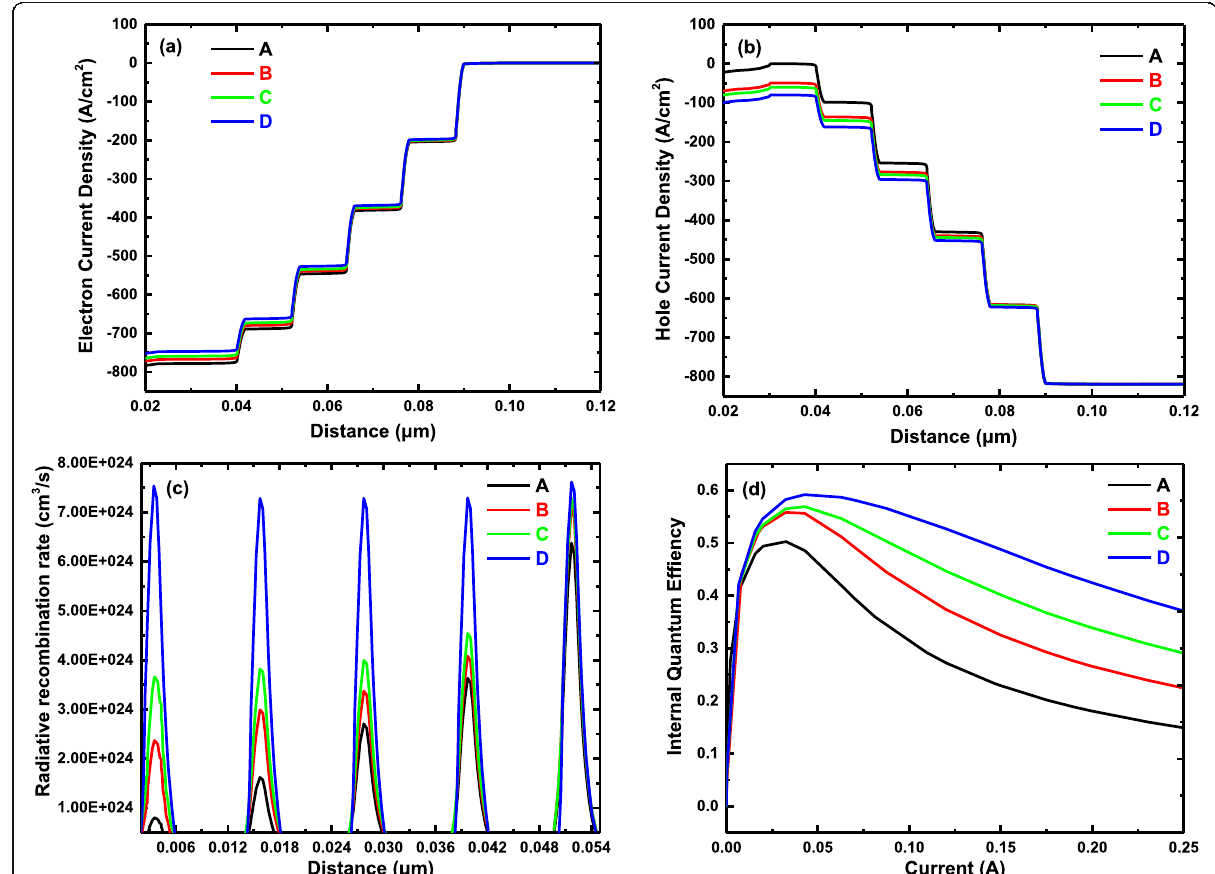
Fig. 4 Theoretical simulations and analysis. a Electron current density in the active region at the injection current of 200 mA. b Hole current density in the active region at the injection current of 200 mA. c Radiative recombination rate in the multiple quantum wells at the injection current of 200 mA. d Dependence of calculated IQE on the injection